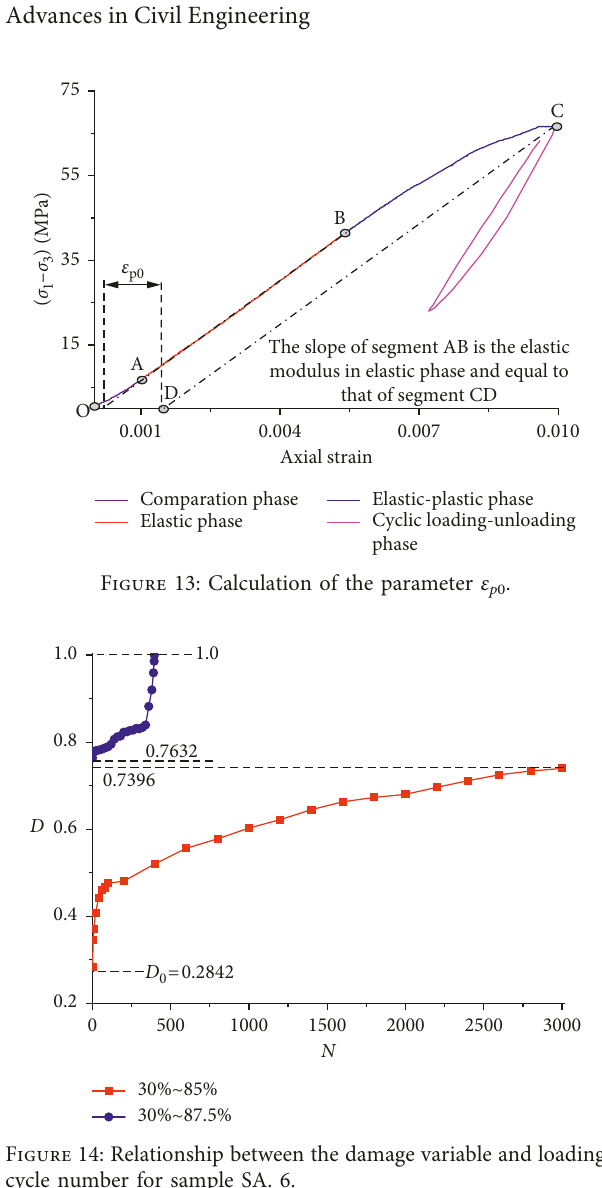
Figure 14: Relationship between the damage variable and loading cycle number for sample SA.